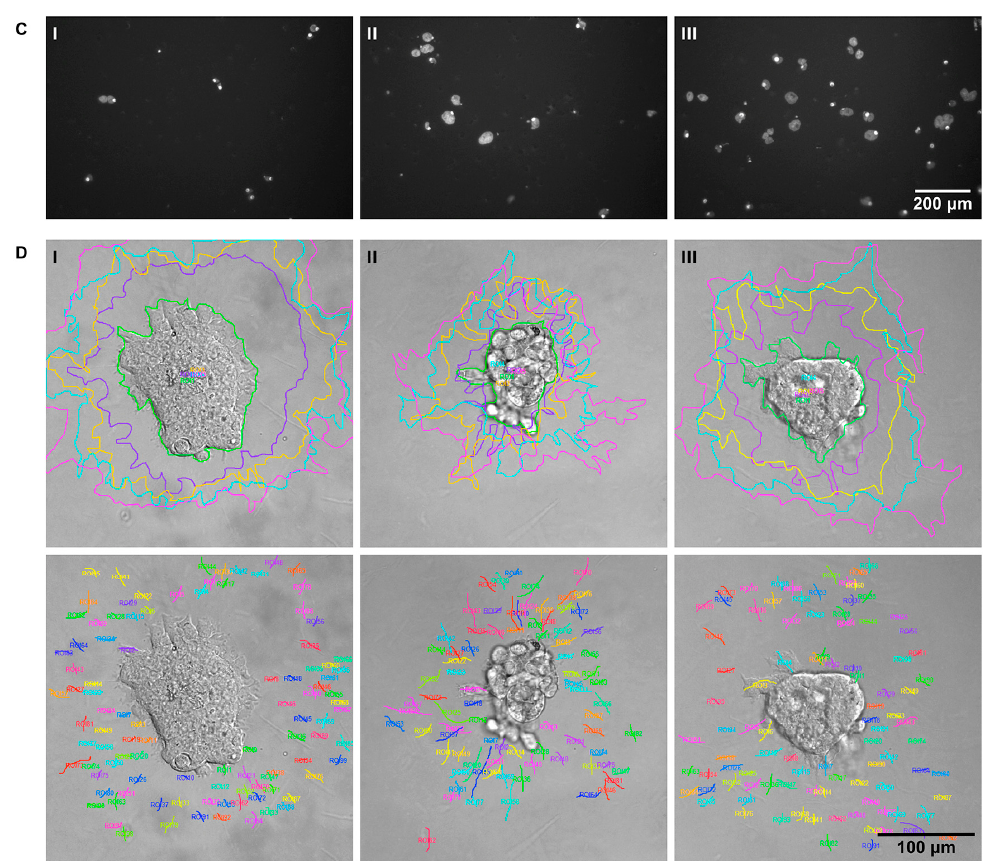
Figure 4. Effect of CDH1 germline missense variants on the invasive and migratory properties of cells. ( A ) Migratory behaviour of Chinese Hamster Ovary (CHO) cells transfected with CDH1 variants. Panel ( AI ) illustrates cells with decreased motility, ( AII ) exhibits a compact front of migration with unidirectional movement of cells, and ( AIII ) shows random colonization of the wound. Pictures were captured in phase contrast microscopy (200×), 8 h after wound incision. ( B ) Illustrative scheme of the non-invasive, invasive, and highly invasive phenotypes. ( C ) Invasive behaviour of cells expressing CDH1 variants in matrigel-coated insert wells. The invasive cells on the lower part of the insert membranes were stained with DAPI. ( CI ) Represents cells with a non-invasive phenotype, ( CII ) represents cells with an invasive phenotype, and ( CIII ) shows cells with a high invasion rate. ( D ) Structural organization (upper panel) and protrusion formation (lower panel) of cellular spheroids embedded in collagen were monitored by time-lapse (400×). The area, as well as protrusion trajectories over time, are marked by colored traces. Cells forming compact aggregates and short protrusions are displayed in ( DI ). ( DII ) Shows a small multicellular structure with lower number of cells but more extended protrusions. In ( DIII ), cells form a more extensive and disorganized structure with large protrusions, indicating a highly invasive phenotype. The data in panels ( A – C ) are in accordance with previously described methods [27,50,79]. Novel strategies and phenotypes to better evaluate CDH1 mutation variants are illustrated in panel ( D ). As the process through which invasive cells leave the epithelium and cross the basement membrane involves proteolytic degradation by the matrix metalloproteinase (MMPs) [84], additional assays can be performed to evaluate whether cells harbouring deleterious variants of E-cadherin lead to increased protease secretion. Although informative, this assay is not routinely used. Very recently, and taking advantage of the morphological changes that cells undergo to escape the epithelium and invade adjacent tissues, we have established an innovative approach using 3D